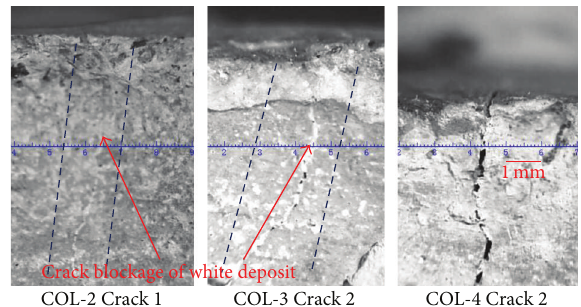
Figure 7: Self-healing effect of cracks after 75 rounds of alternate exposure.